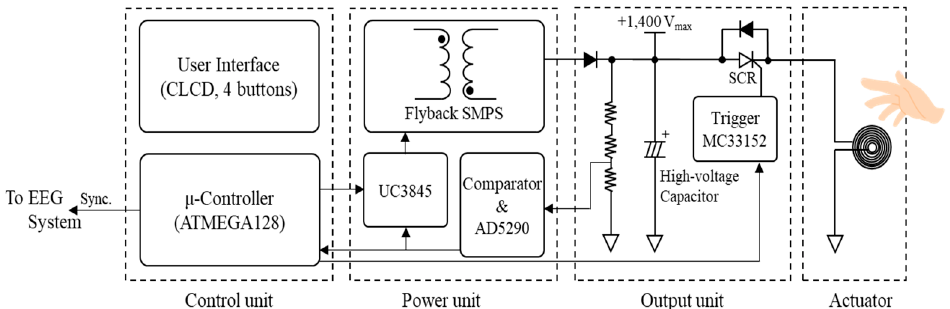
Figure 1. Overall configuration of the tactile stimulator based on a time-varying magnetic field (TSTM).